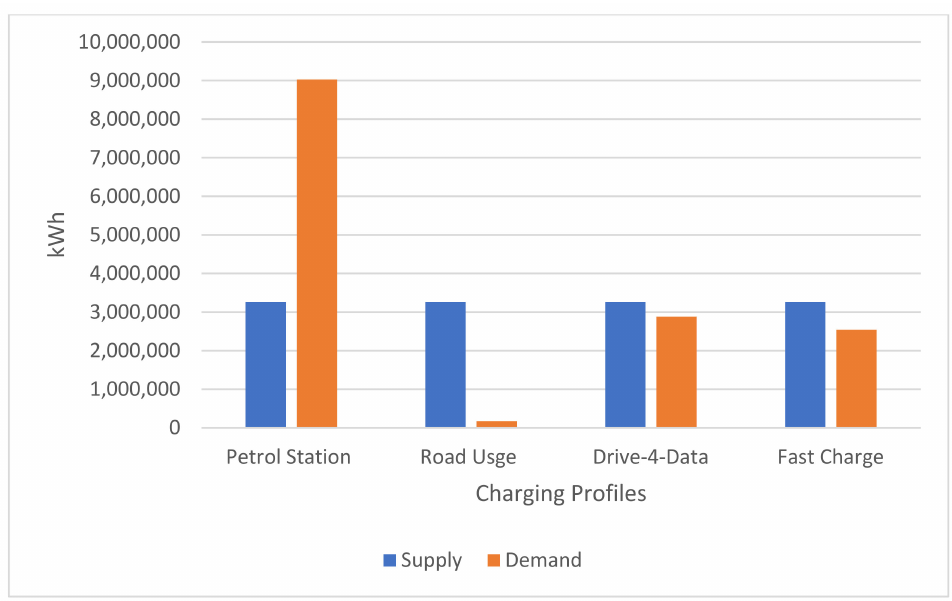
Figure 7. The annual power supply and demand of the PVEVCS in each charging profile.